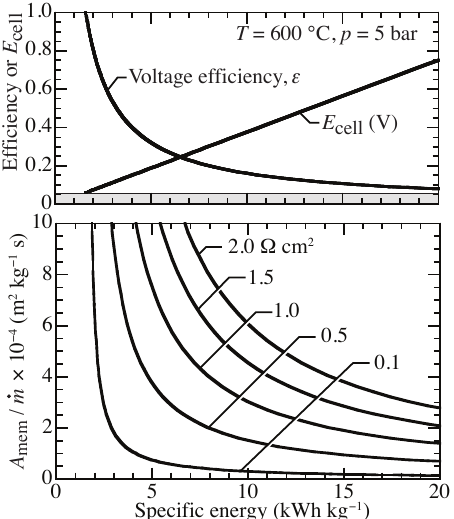
Figure 10. Isothermal electrochemical compression from 1 to 5 bar across a proton-conducting membrane at 600 ◦ C with ASR between 0.1 Ω cm 2 and 2 Ω cm 2